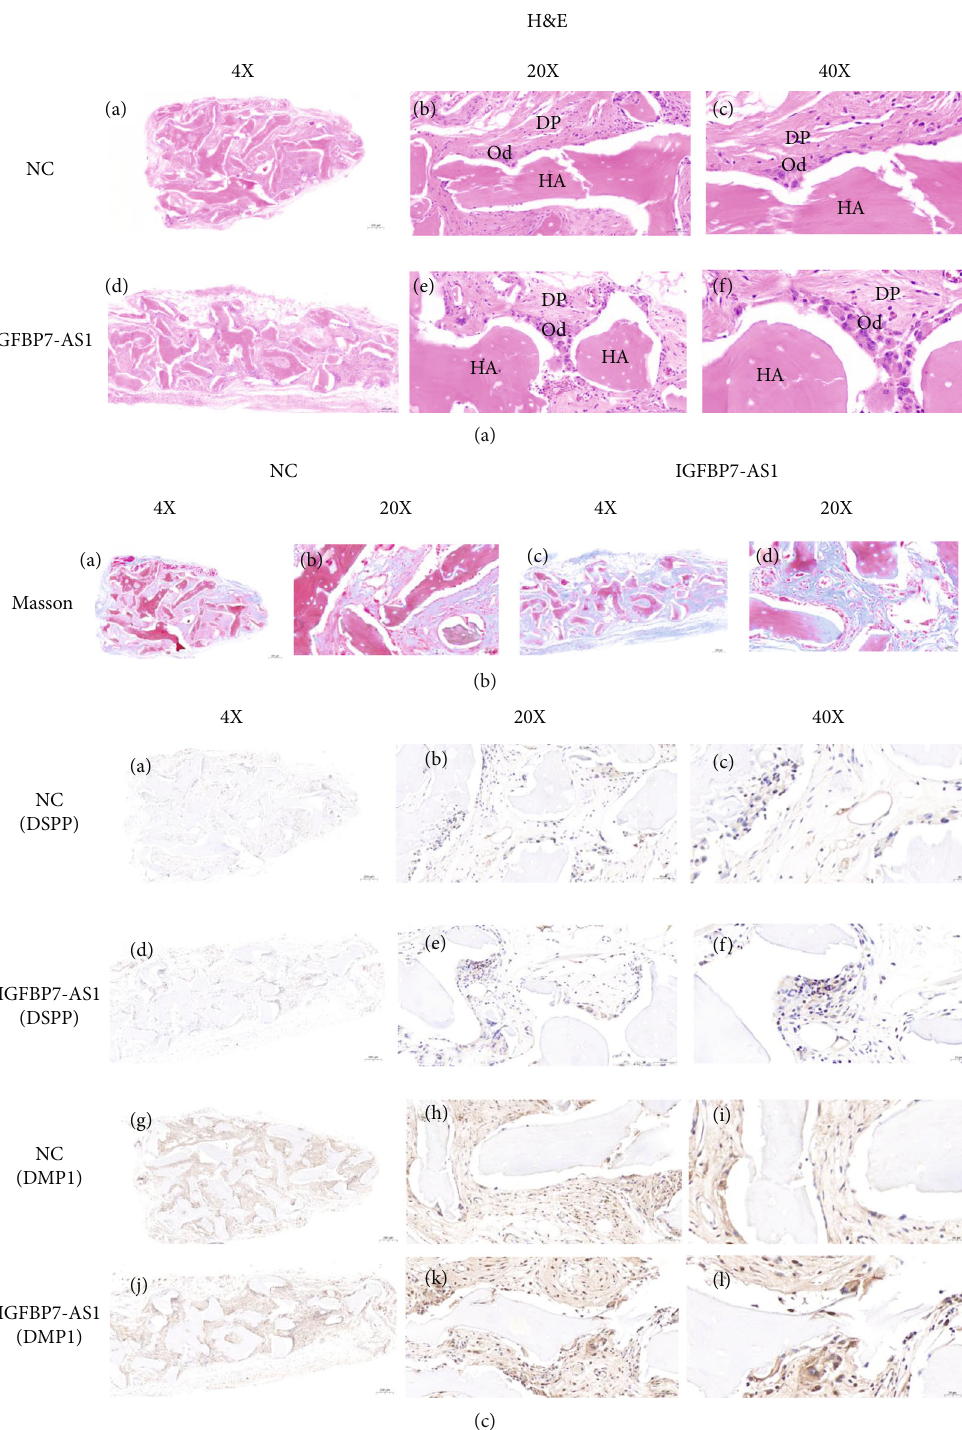
Figure 5: Subcutaneous transplantation results on 8 weeks showing that IGFBP7-AS1 promotes the odontogenic di ff erentiation of SHED in vivo . (a) H&E staining, (a – c) NC group, and (d – f) IGFBP7-AS1 group. (b) Masson staining. (c) Immunohistochemistry staining, (a –